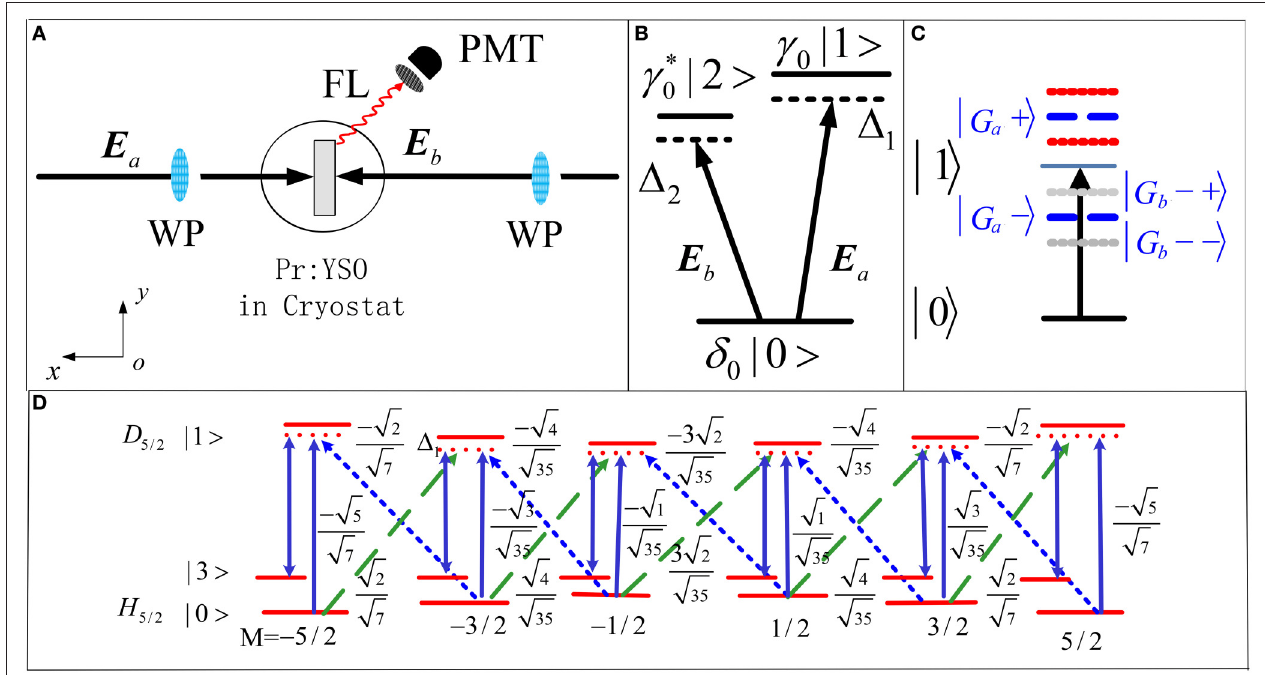
FIGURE 1 | (Color on-line) (A) experimental setup scheme, where Photomultiplier tube (PMT) and wave plate (WP) are used. (B) V-type system (|0 i↔ |1 i↔ |2 i ). (C) Shows dressed state picture for V-type system. (D) Zeeman energy-levels and transition paths at different polarization states. Solid lines: transitions for the linearly polarized beam; dotted lines: transitions for the left circularly polarized beam; dashed-lines: transitions for the right circularly polarized